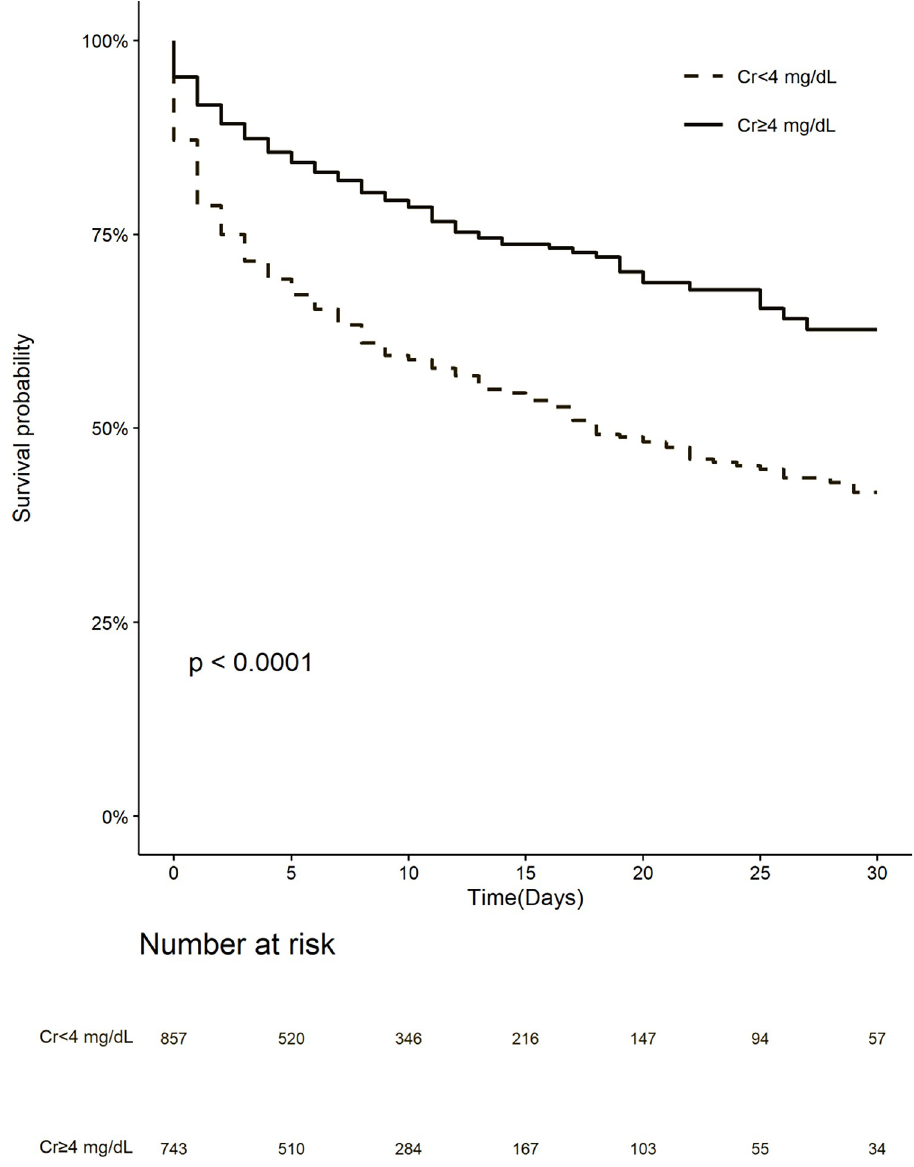
Fig 2. Kaplan–Meier curve of mortality according to creatinine category. The low-creatinine (Cr < 4 mg/dL) group was associated with worse survival than the high-creatinine (Cr � 4 mg/dL) group.